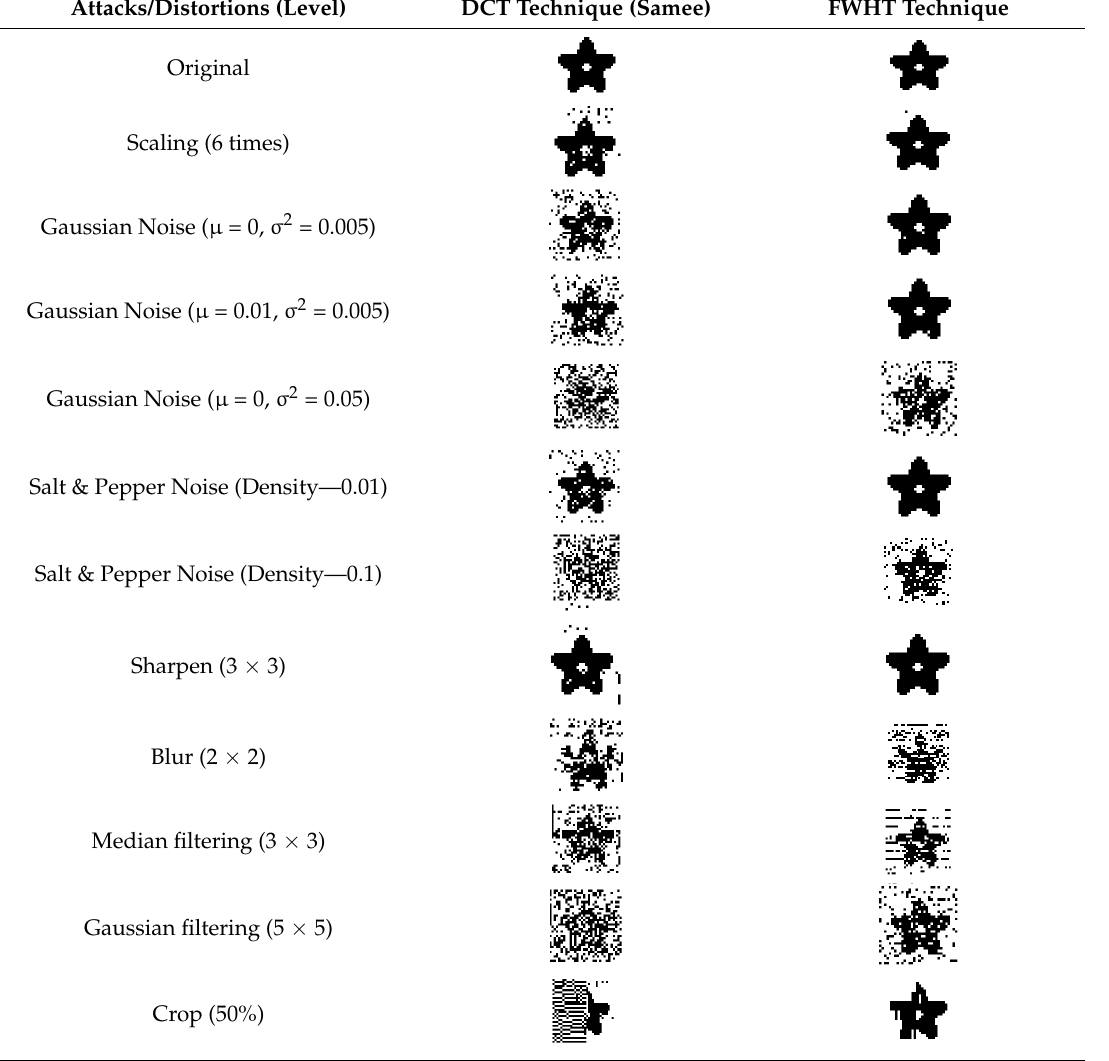
Figure 5. Compression Quality Vs BER for proposed technique (FWHT) and for similar DCT technique. Table 2. Extracted watermark After Different Attacks.